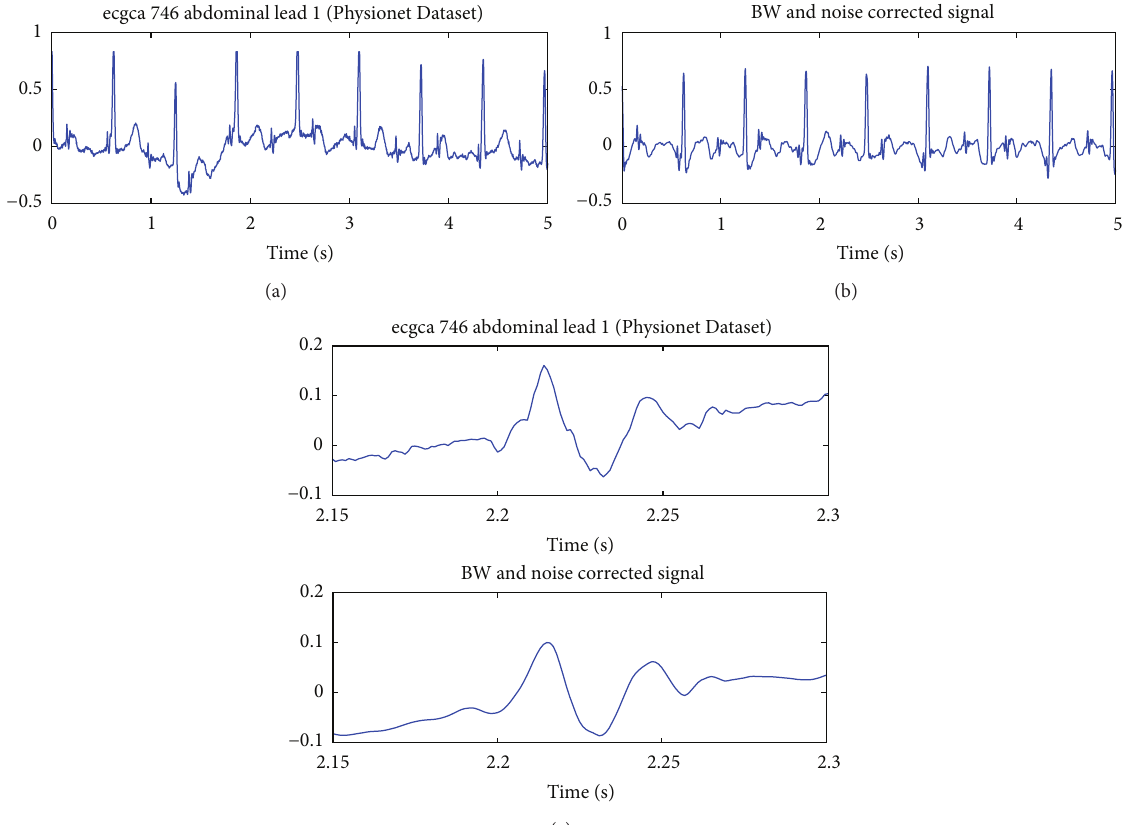
ecgca 746 abdominal lead 1 (Physionet Dataset)